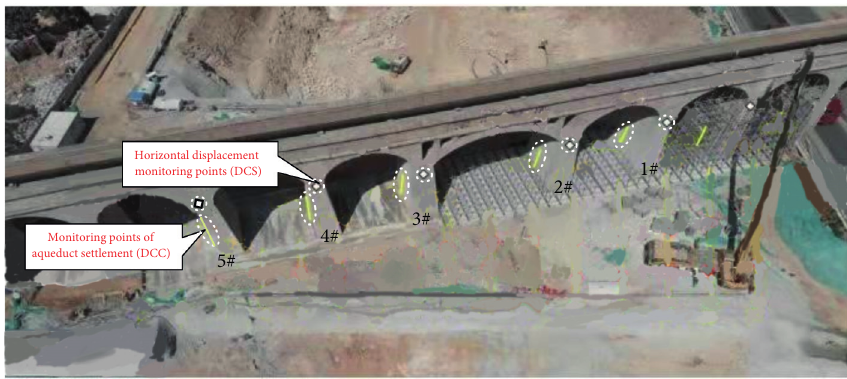
Figure 12: Measuring point